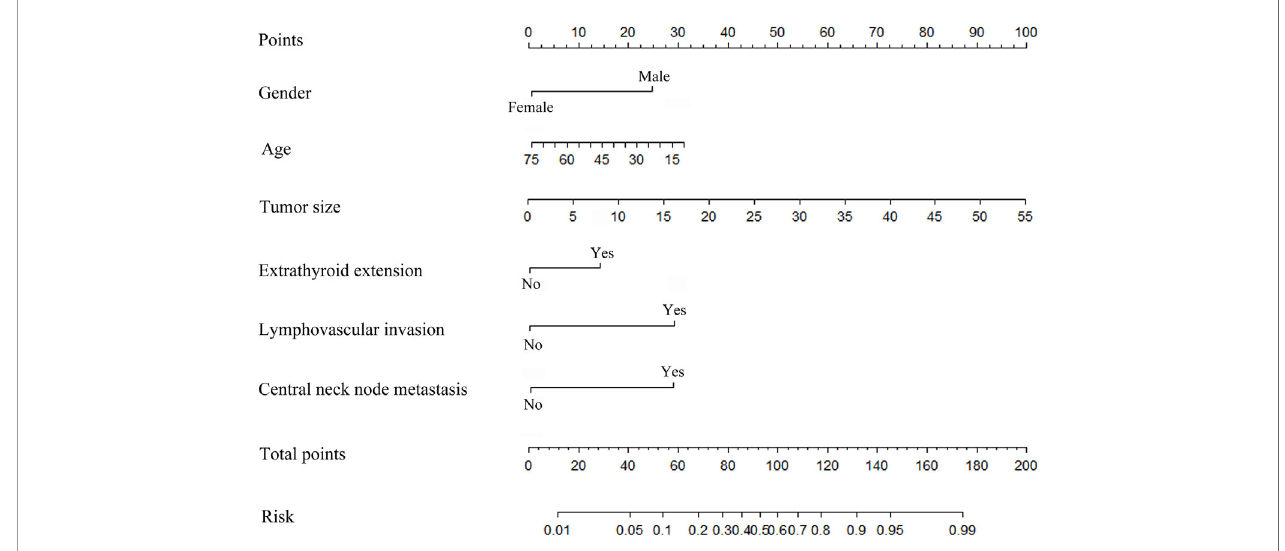
FIGURE 6 | Risk factor-based nomogram for predicting DLN metastasis. Predictor points ( “ Points ” scale; top) correspond to each